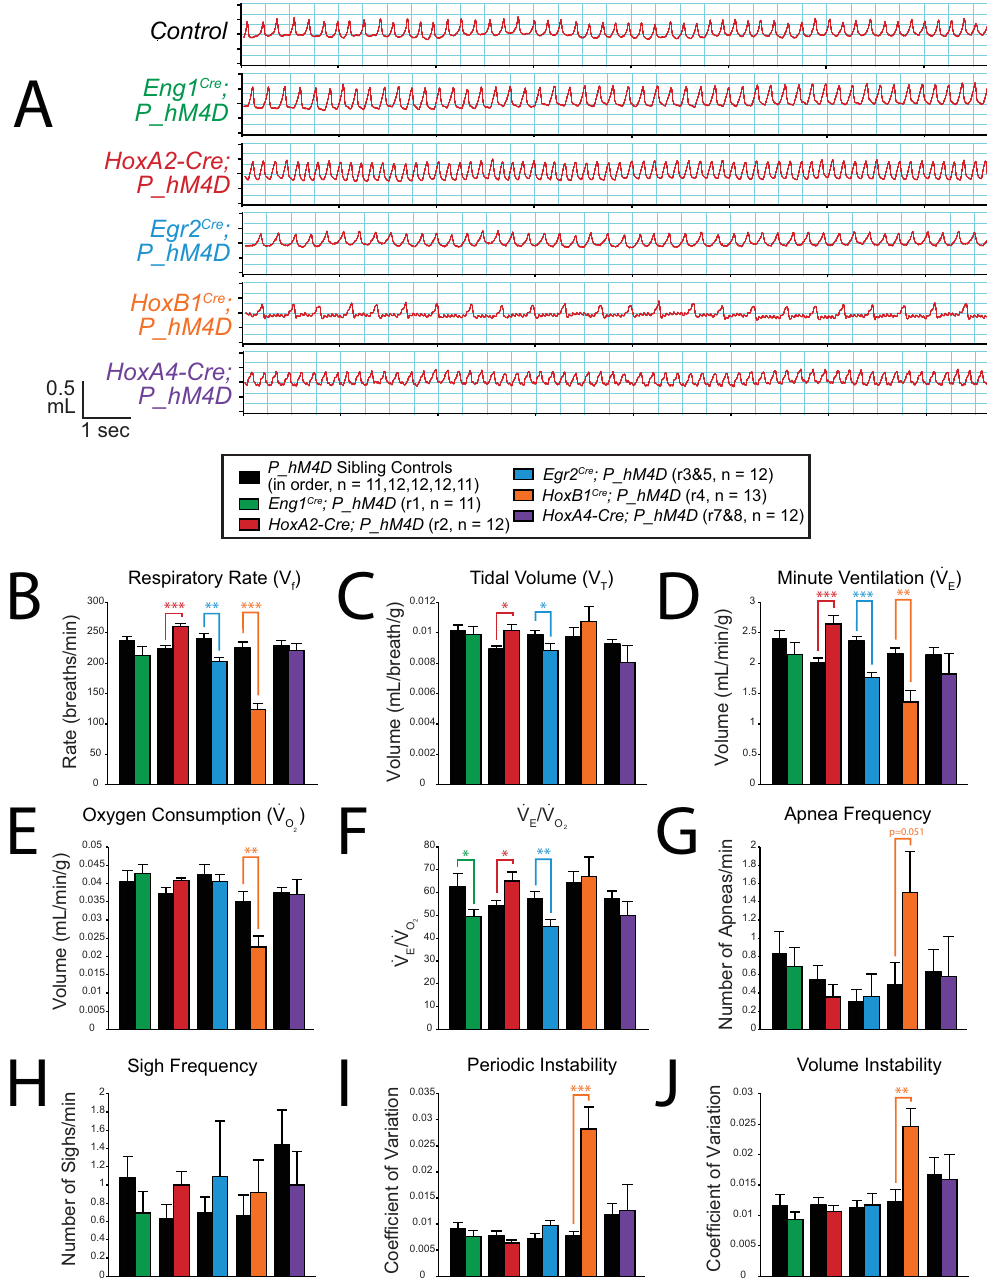
Figure 5. CNO-hM4D perturbation of rhombomeric domains in the adult animal results in a variety of respiratory phenotypes under hypoxic (10% O 2 ) conditions. ( A ) Representative traces of respiratory wavesforms in P_hM4D sibling controls and rhombomere-Cre; P_hM4D mice after CNO injection under hypoxic conditions. ( B–F ) Quantification of pre- and post-CNO respiratory parameters. Perturbation of rhombomere- derived populations under hypoxic conditions results in increases, decreases, and no change in respiratory rate ( B ), tidal volume ( C ), minute ventilation ( D ), oxygen consumption ( E ),  V frequency ( H ), periodic instability ( I ), and volume instability ( J ) as compared to sibling controls. Statistical significance was determined using a linear mixed-effects regression model with animal type (experimental or control) as a fixed effect. * p < 0.05, ** p < 0.01, *** p <